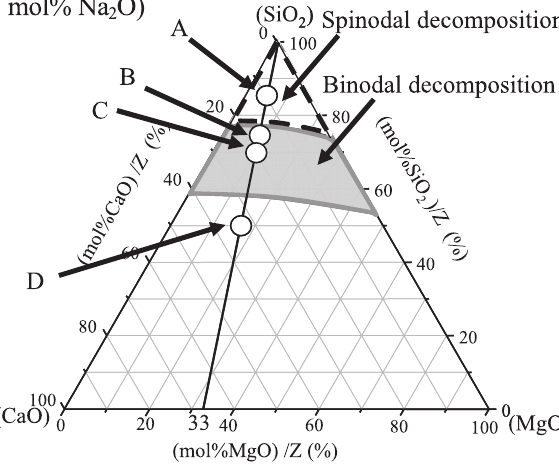
Fig. 2: Calculated composition ranges of spinodal and binodal -CaO-MgO-5 mol% Na decomposition in the SiO 2 + CaO + MgO), A-D: glass compositions used (Z = mol% (SiO 2